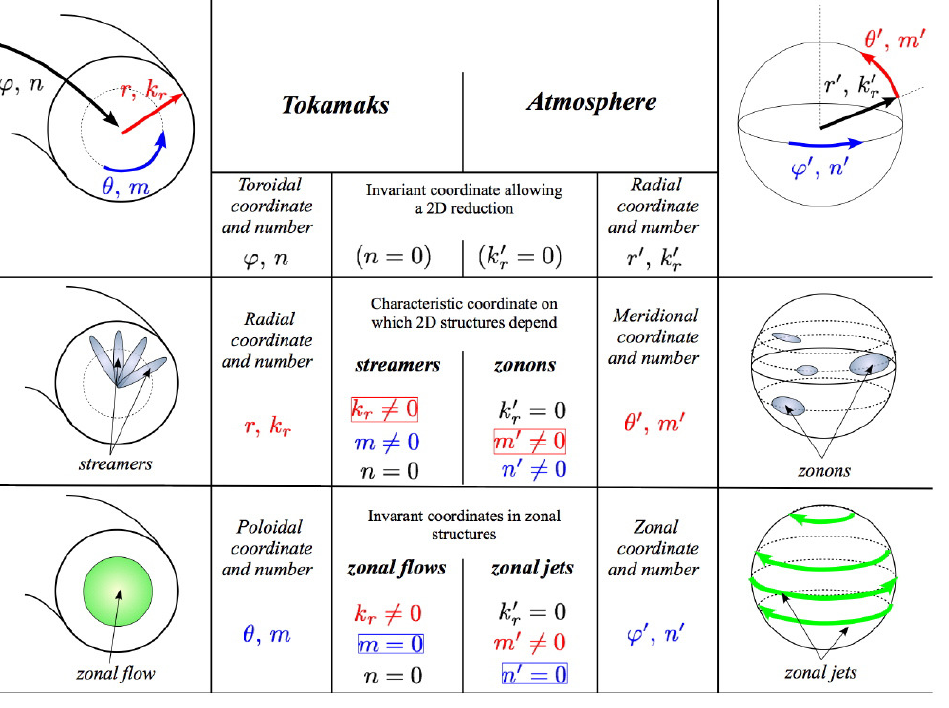
Figure 11. Basic mesoscale structures met in tokamak device (streamer and zonal flow) at left. The right side illustrates the corresponding mesoscale structures (zonons and zonal jets) found in the atmosphere. In the 2D description of drift-kinetic turbulence in a tokamak, the restriction to a planar geometry corresponds to the k ϕ = 0 condition, which holds for both zonal flows and streamers. In the 2D description of zonostrophic turbulence, the restriction to a 2D geometry is given instead by the condition k r (cid:48) = 0. The correspondence between the ( r , θ , ϕ ) set of toroidal coordinates in drift-kinetic turbulence in tokamaks and the ( r (cid:48) , θ (cid:48) , ϕ (cid:48) ) set of spherical coordinates in zonostrophic turbulence in the atmosphere is shown